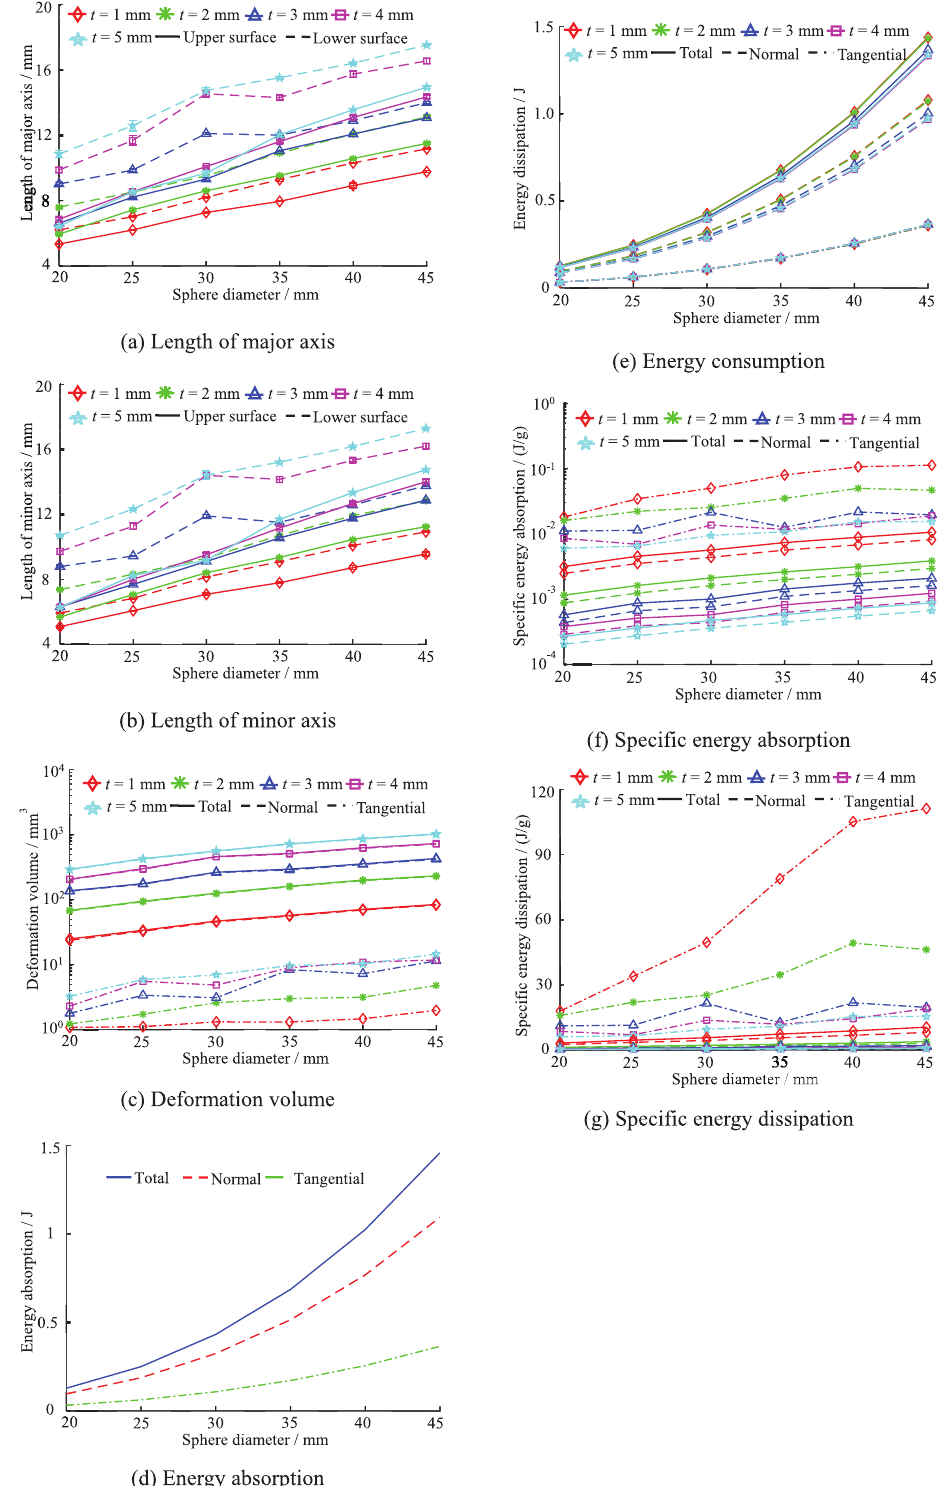
Fig. 5. Geometrical characteristic sizes of contact surface, deformation volume and speci fi c energy parameters at different sphere